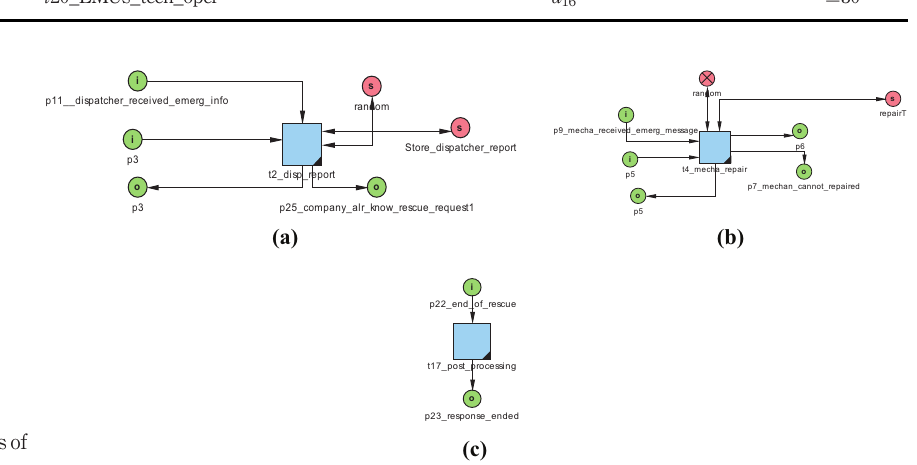
Table 3. Limitations on the emergency response time for high-speed railway operation